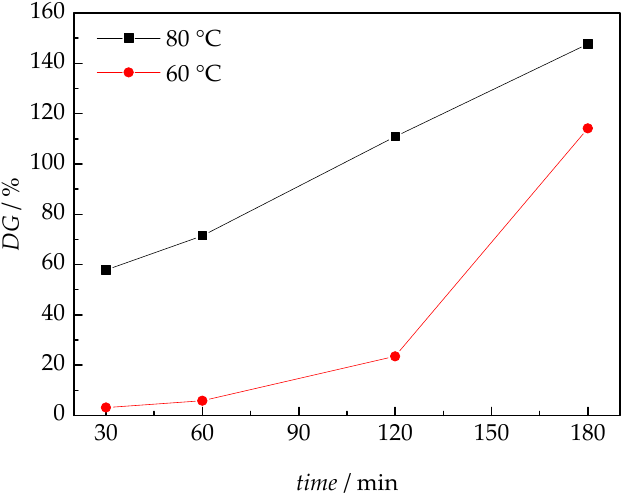
Figure 2. Influence of reaction temperature on the DG with x 2 = 40 vol %, x 3 = 40 kGy, 85 mol % GMA, 10 mol % HEMA, and 5 mol % MBAA.